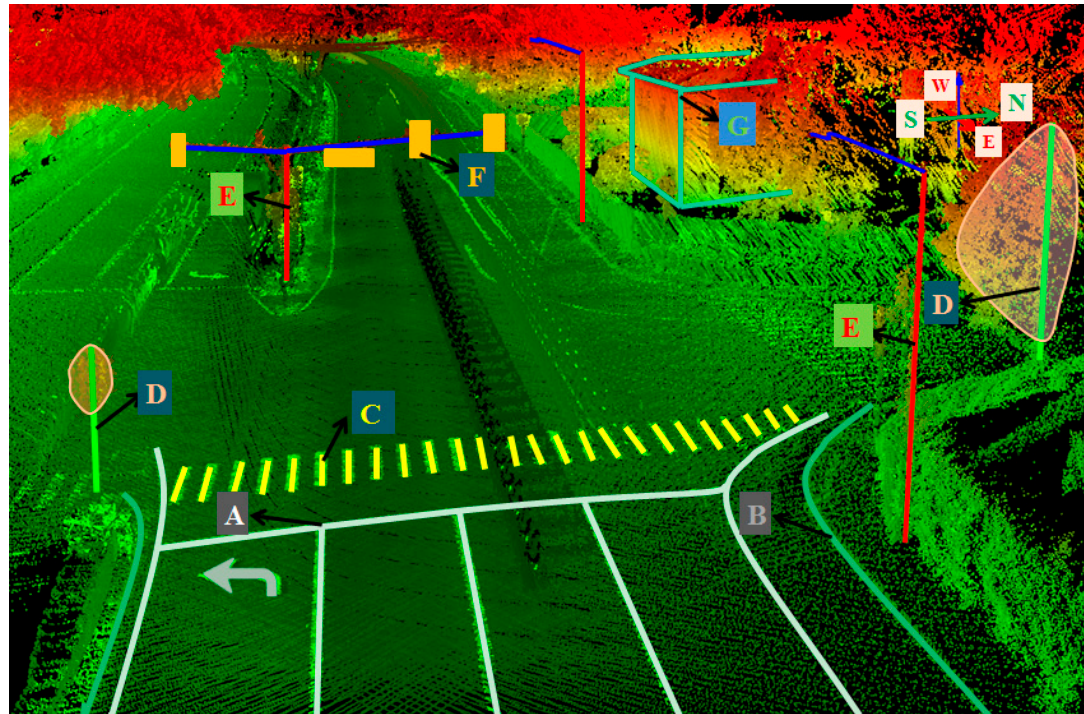
Figure 3. Urban scene mapping and modeling based on MLS data. The objects are roughly detected from the more detailed MLS point clouds. The A represents road markings, the B represents road curbs, the C represents zebra stripes, the D represents trees, the E depicts street poles, the F depicts traffic light or advertising boards, and the G depicts buildings.